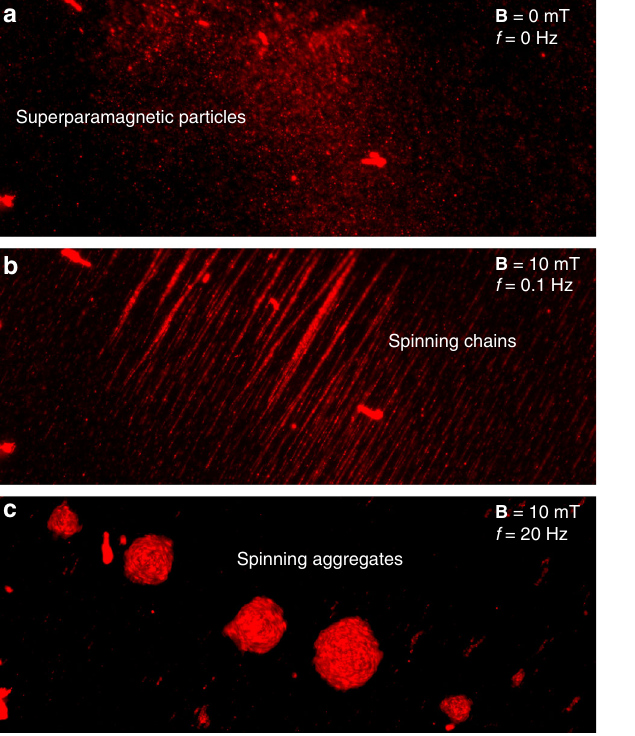
Fig. 3a – c. The vortex width w , which is de fi ned as the distance between the starting and ending vertex points of a vortex, decreases as the diameter of the particles increases as the radiation force becomes prominent. Conversely, the 10 and 15.5 µ m particles migrate transversely towards the ± x direction and become trapped at the sidewalls, as shown in Fig. 3d and e (see also Supplementary Movie 1). Supplementary Figure 4 demonstrates the trapping of ~6 µ m superparamagnetic particles, whereas, similar size polystyrene particles follow the fl ow streamlines. The experiment results closely agree with the analysis, as shown in Fig. 2d and e (see also Supplementary Movie 2).